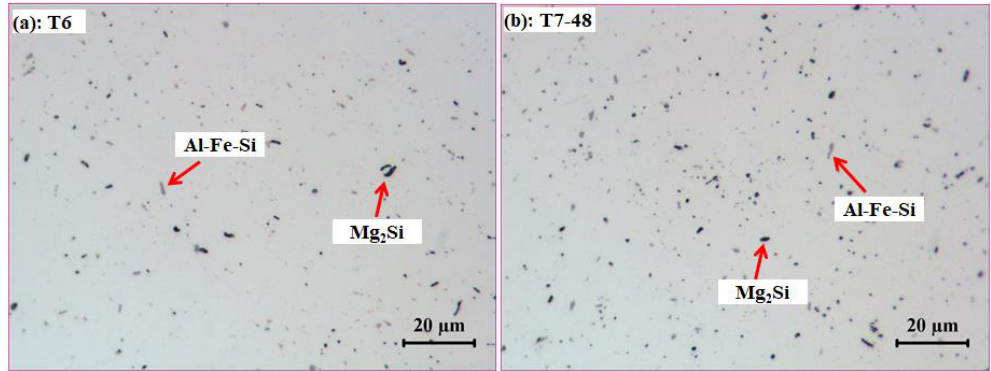
Figure 2. Microstructure of the experimental 6061 alloy under ( a ) T6 and ( b ) T6 further aged for 48 h (T7-48) conditions.